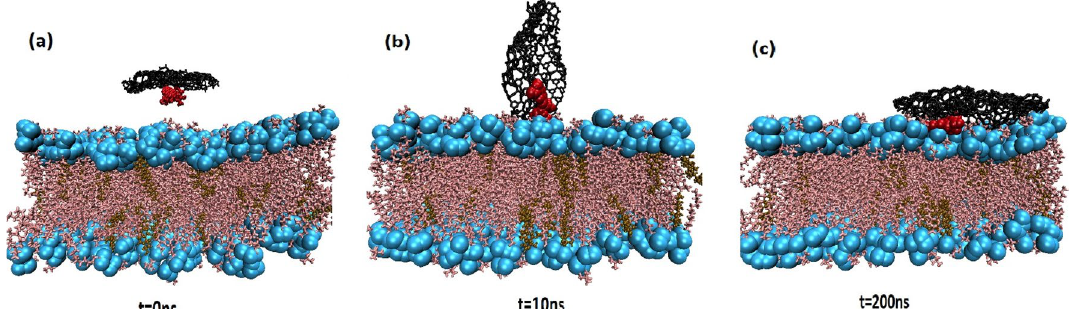
Figure 7. Evolution of the progressive insertion of CN-DOX into the lipid bilayer at three times of the simulation. ( a ) 0 ns, ( b ) 10 ns, ( c ) 200